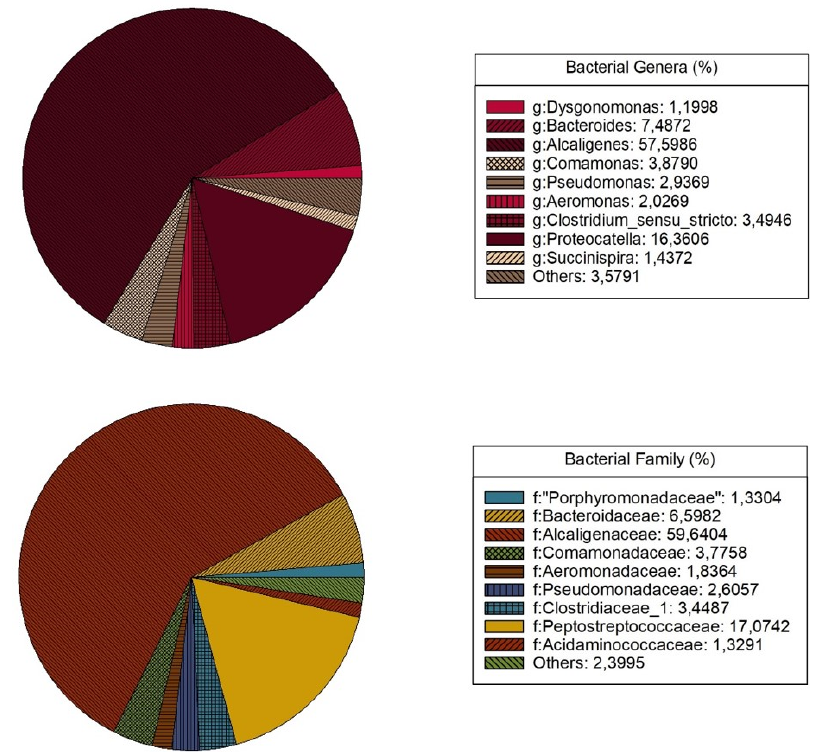
Figure 1. Taxonomic approach to the microbial families and genera found in samples from the ETP. Total DNA was extracted from the ETP´s samples. Bacterial 16S rDNA was amplified and enough product was delivered to a sequencing company. The information obtained allowed us to describe the relative abundances of known microbial genera present in the samples. More details in the Materials and Methods section.